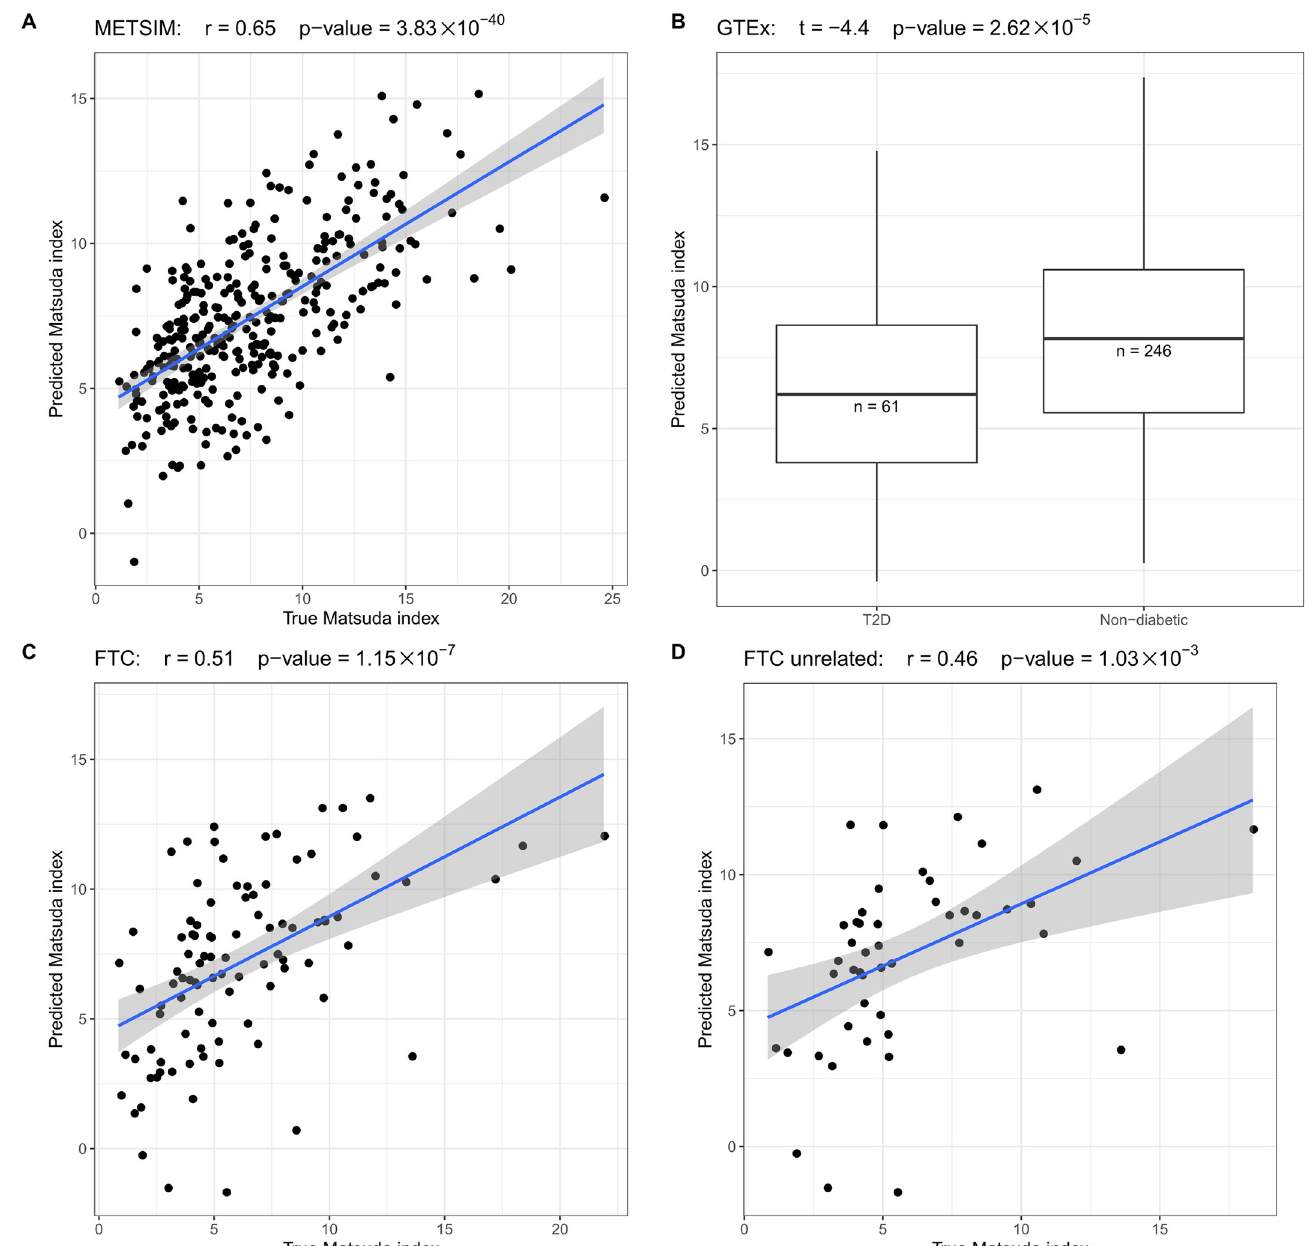
Fig 4. The predicted Matsuda index is well concordant with the true Matsuda index values in 3 different cohorts: METSIM, GTEx, and FTC. (A) In METSIM, the estimated and true Matsuda index are significantly associated. (B) In GTEx, the predicted Matsuda index is significantly higher in non-diabetic individuals when compared to the T2D patients. (C) In FTC, the estimated and true Matsuda index are significantly associated. (D) We randomly choose one individual from each twin pair to select the unrelated individuals from FTC. Among the unrelated individuals, the estimated and true Matsuda index are also significantly associated, indicating that the twin status did not bias the prediction of the Matsuda